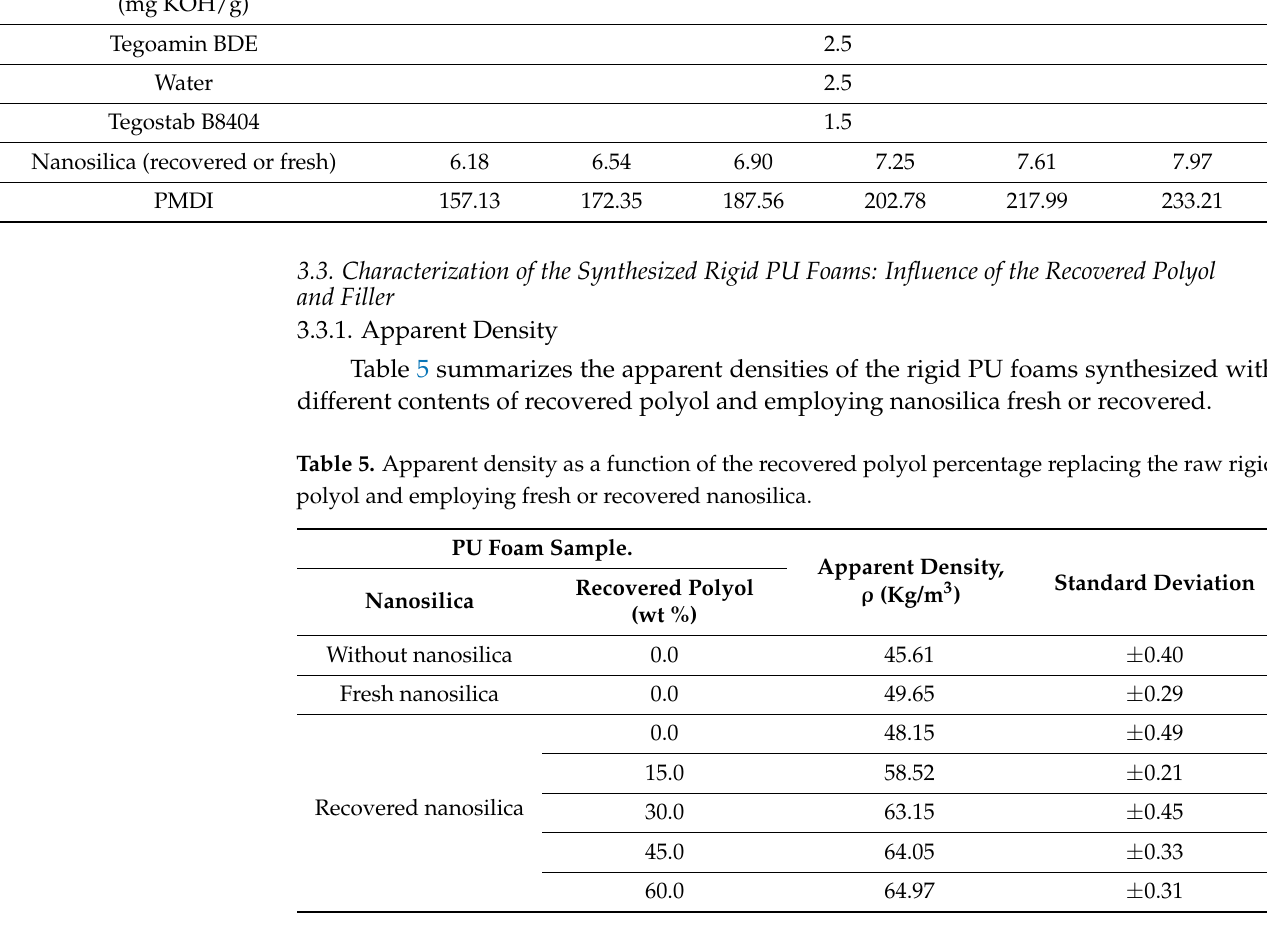
Table 4. Foaming experiments carried out (reagents contents in pph of polyol, P = raw polyol and R = recovered polyol). P100 Raw rigid polyether polyol OH = 455 mg KOH/g